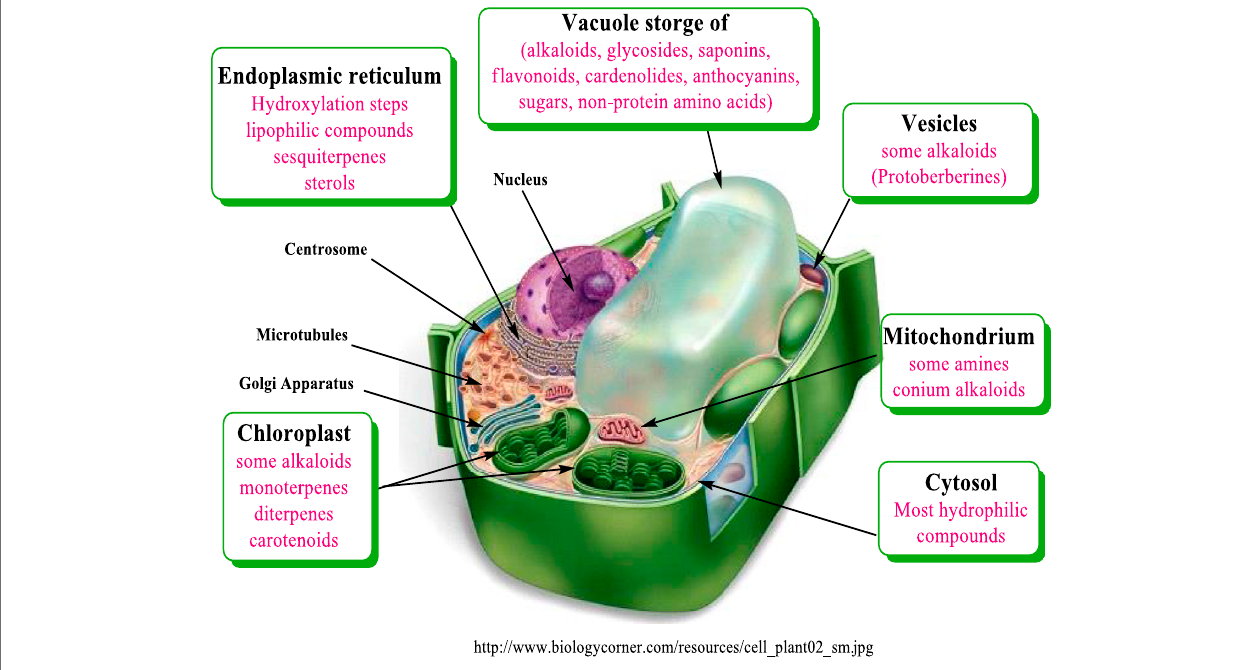
FIGURE 2 | Compartments of biosynthesis and storage for plant secondary metabolites modi fi ed from Wink (1999).